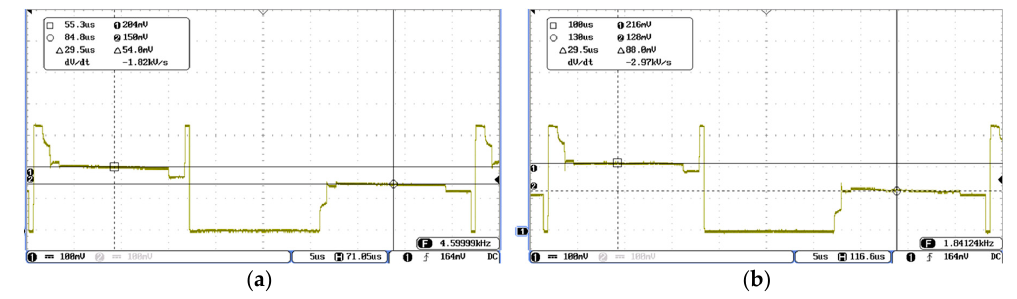
Figure 8. Two-layer design: ( a ) “released” signal; and ( b ) “pressed” signal.